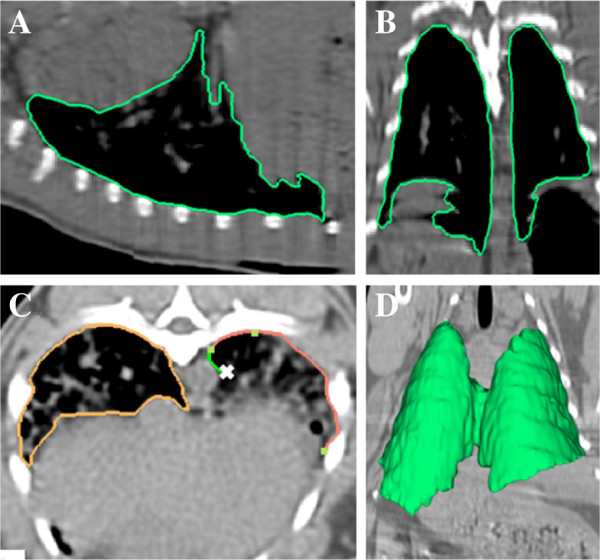
Sample delineation process via LW. Sagittal (A), coronal (B), and axial (C) plane from a rabbit CT scan. As seen in (C), the user provides guidance by clicking a few anchor points and LW automatically traces the boundary of interest between anchor points. (D) 3D visualization of the segmented lungs, at the end of LW process, is shown in green.